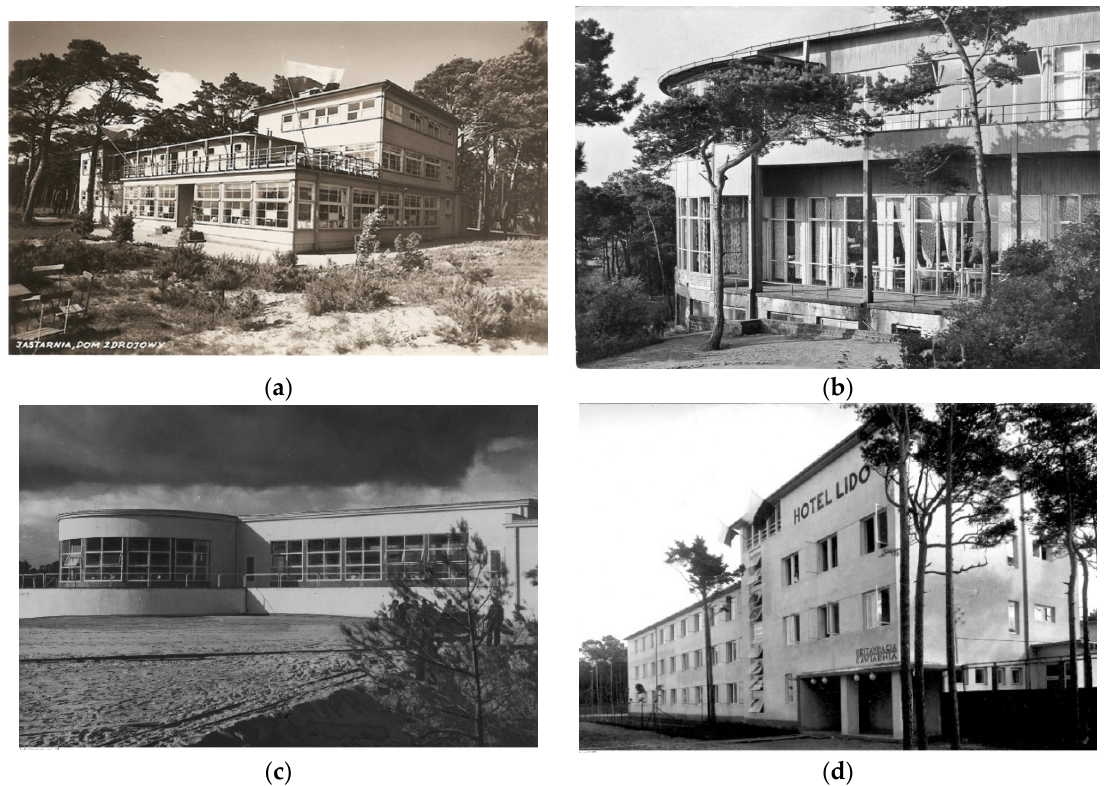
Figure 6. Modernist architecture: Spa House in Jastarnia ( a , b ), Cafe Casino in Jurata ( c ), Lido Hotel ( d ). Source: fotopolska.eu ( a ); wolneforumgdansk.pl ( b ); The National Digital Archives ( c , d ).